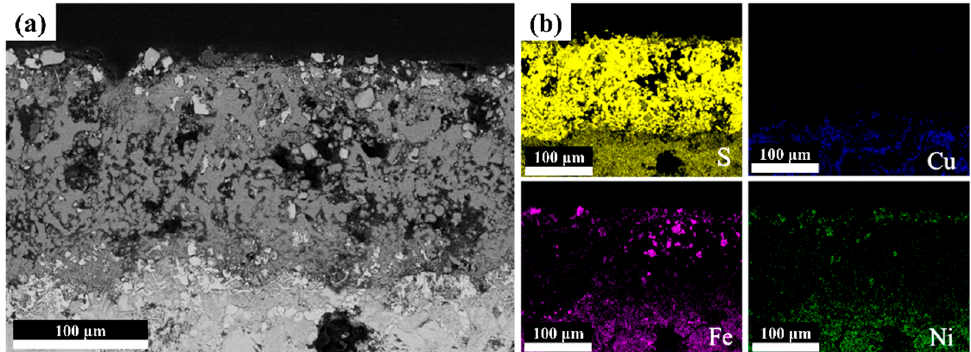
Figure 6. ( a ) SEM image of the low-nickel matte without the addition of quartz sand at 200 RPM for 3 h leaching; ( b ) EDS analyses for the selective areas from ( a ).